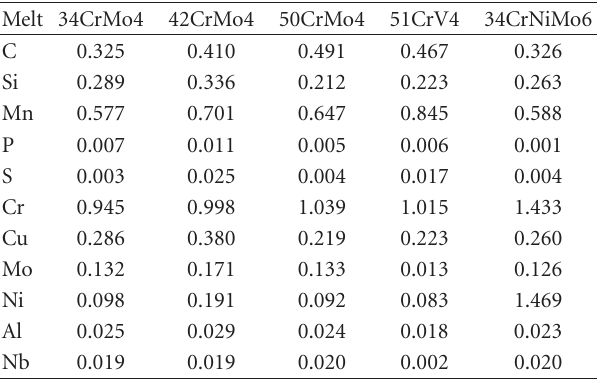
Table 1: Chemical composition of the investigated melts in mass